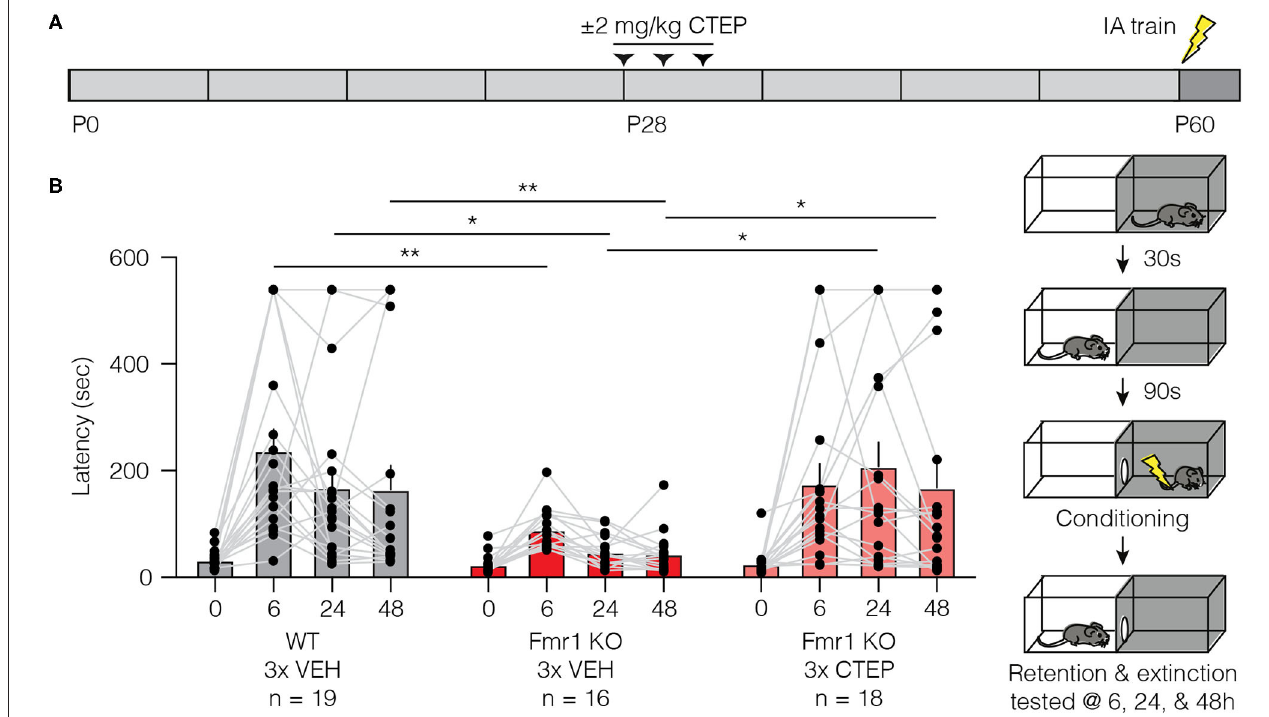
FIGURE 6 | Brief treatment of juvenile Fmr1-KO mice with CTEP normalizes inhibitory avoidance measured 1 month after the end of treatment. (A) Schematic shows when during the developmental timeline CTEP is administered and IA experimental design. (B) There was a statistically significant interaction between treatment and time point (repeated measures two-way ANOVA with Greenhouse-Geisser correction, F (6,150) = 2.684, p = 0.0064). Fmr1-KO mice treated with vehicle displayed impaired acquisition and extinction of IA learning compared to vehicle treated wild type mice (wild type vehicle vs. Fmr1-KO vehicle, Tukey’s post-test at time 0 h p = 0.3488, at 6h p = 0.0048, at 24h p = 0.0116, at 48h p = 0.0444) and CTEP treated Fmr1-KO mice (Fmr1-KO vehicle vs. Fmr1-KO 3x CTEP, Tukey’s post-test at time 0 h p = 0.9756, at 6h p = 0.1024, at 24h p = 0.0067, at 48h p = 0.0416). Data are displayed as mean ± SEM. * p < 0.05, ** p < 0.01.